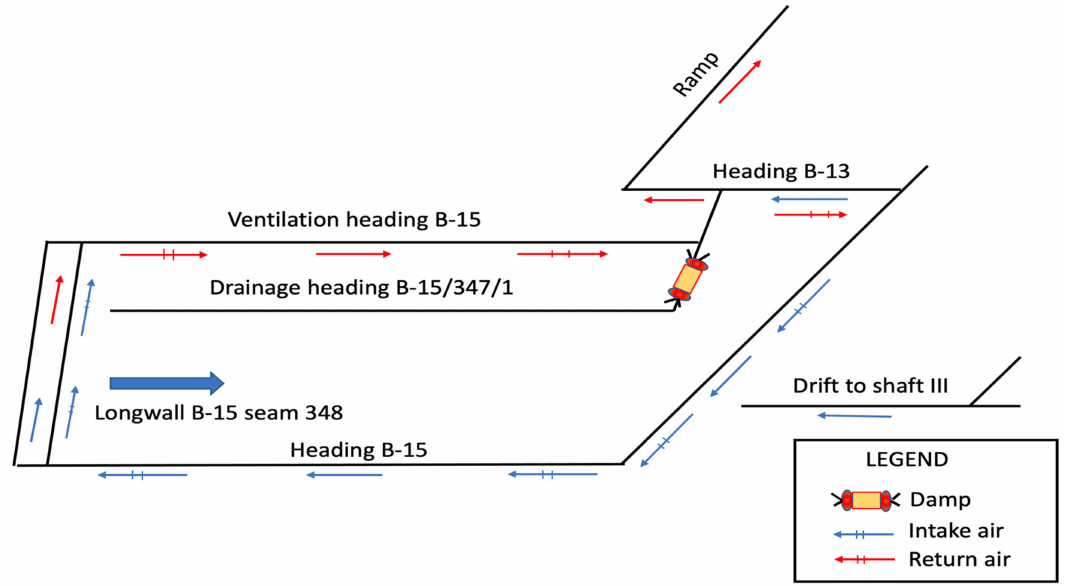
Figure 9. The map of seam 348 with the B-15 longwall area marked in yellow.